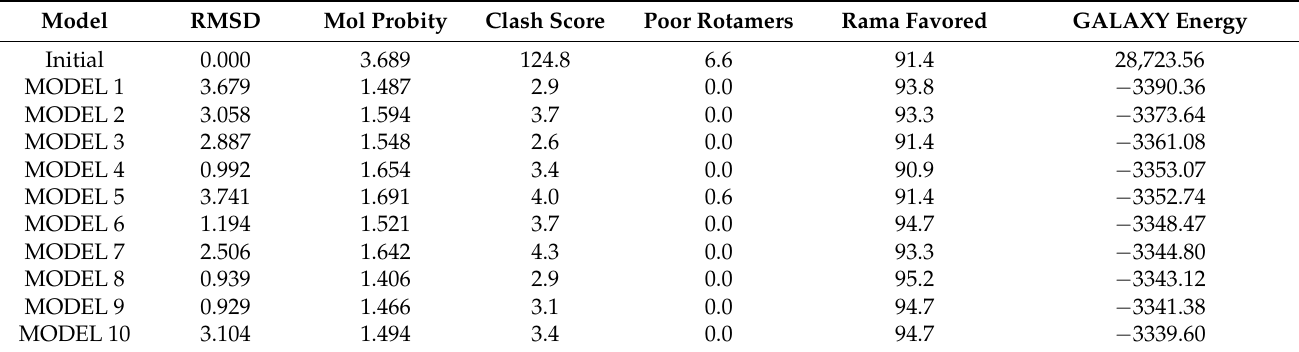
Figure 6. Schematic representation of multi-epitopes vaccine. Table 4. Top refine models generated by GalaxyWeb